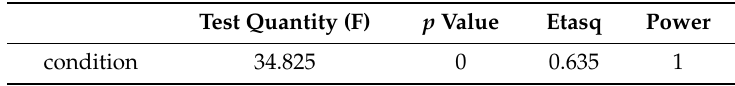
Table 3. Result of the ANOVA of the observation groups one Leg stand with knee flexion and one leg stand without knee flexion.